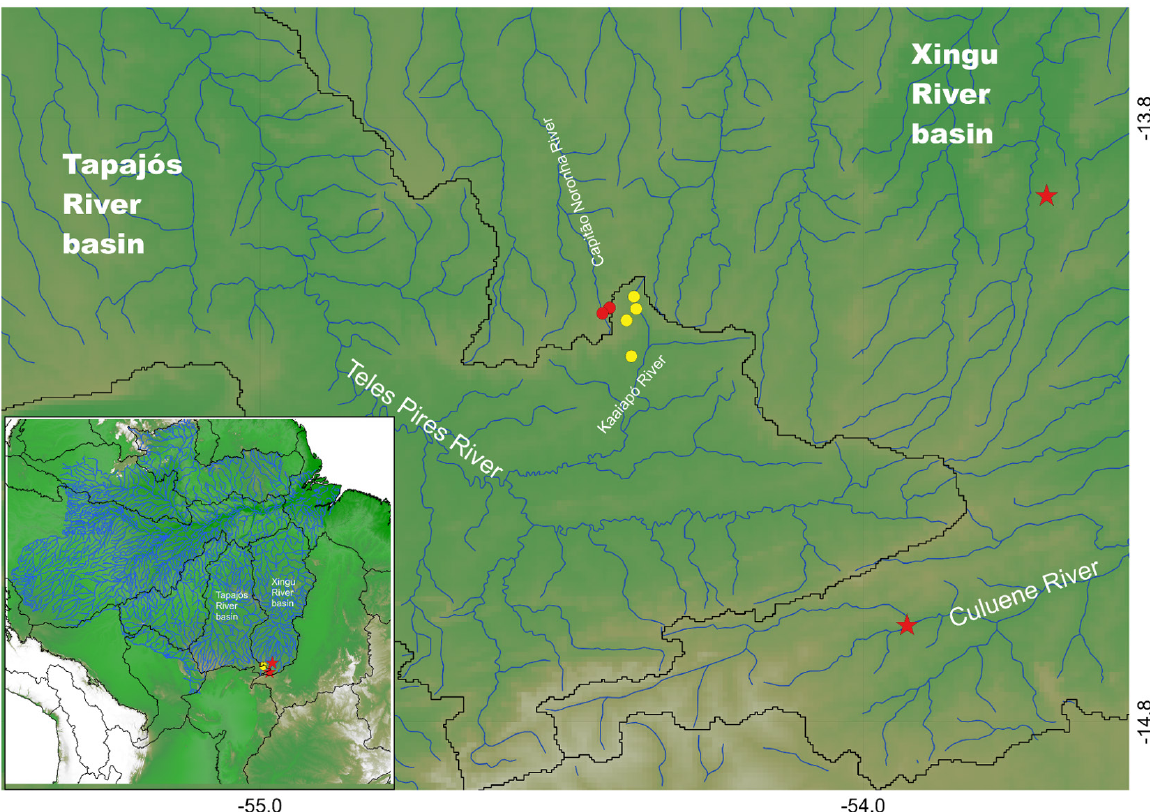
Figure 2. Geographical distribution of Characidium xavante in the Amazon basin in Brazil. Red stars = type specimens; Red dots = new records in the Capitão Noronha River drainage, Ronuro River drainage, upper Xingu River basin; Yellow dots = new records in the Kaaiapó River drainage, Teles Pires River, upper Tapajós River